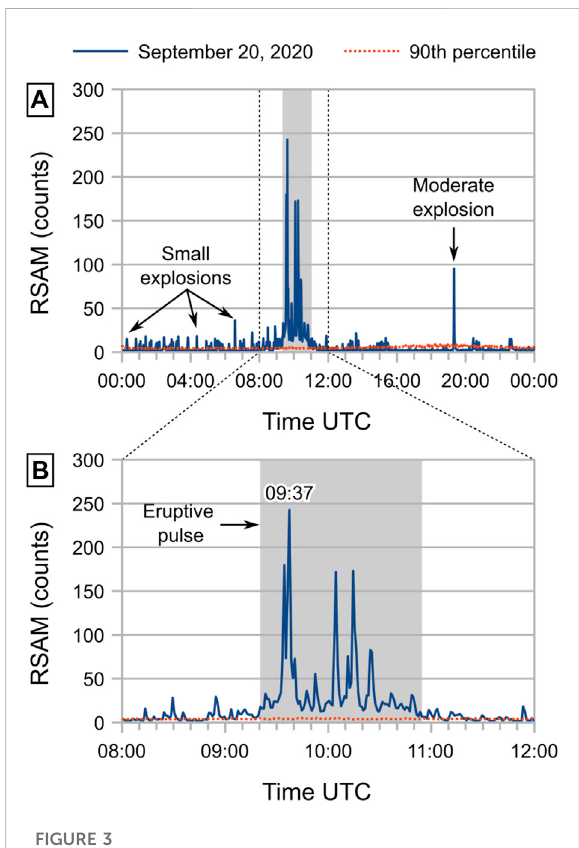
FIGURE 3 Real-time Seismic Amplitude Measurement (RSAM) calculated from PUYO seismic station on (A) September 20, 2020 and (B) from 08:00 to 12:00 UTC with a 0.6 – 1.2 Hz frequency fi ltering, in digital counts. Red dotted line corresponds to the 90th percentile of all values for that minute in the day since PUYO was installed in 2012 (see text for description); grey area corresponds to the duration of the eruptive